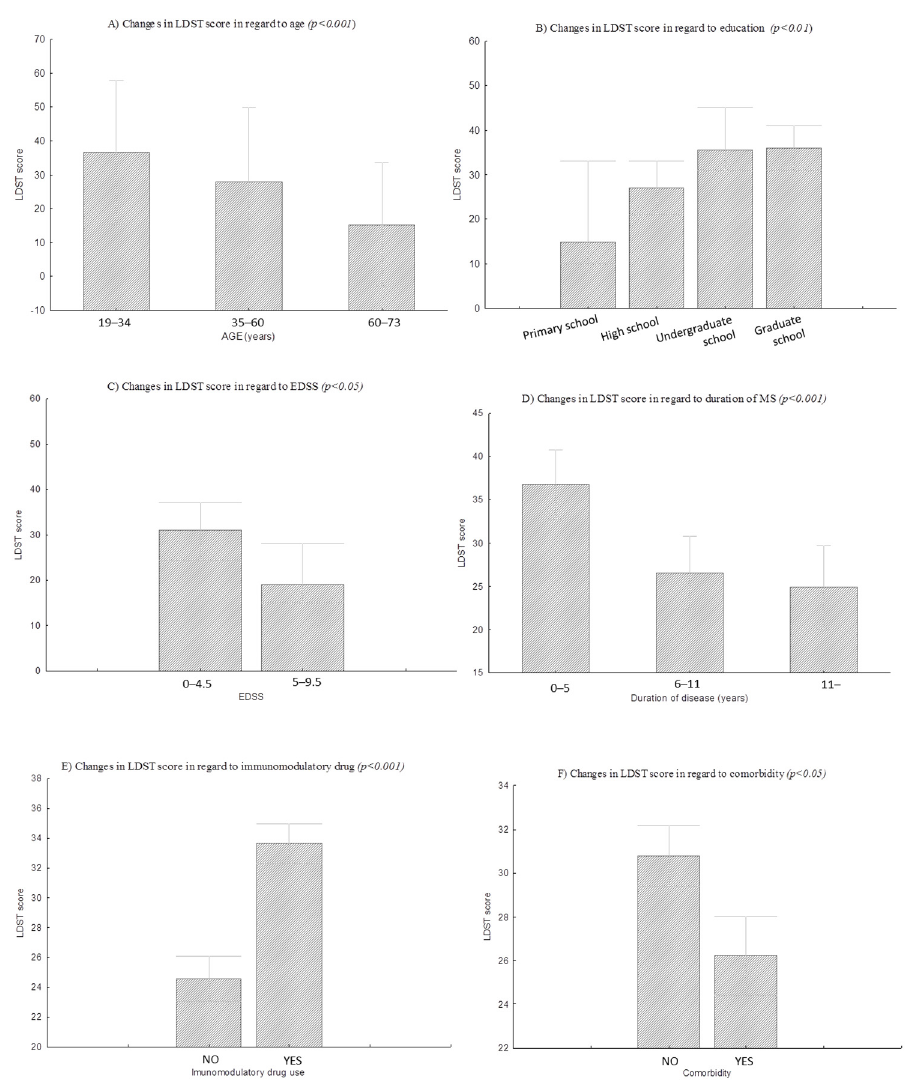
Figure 2. Changes in LDST performance regarding age, education, EDSS, duration of disease, comorbidity, and immunomodulatory drug use in pwMS.